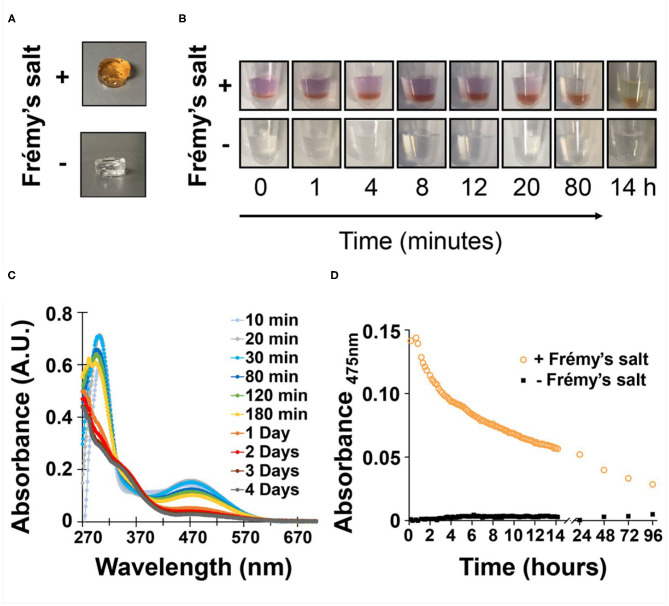
(A) Images of pre-formed gels following overnight incubation in the presence or absence of Frémy's salt. Changes in gel color observed only in the presence of Frémy's salt overtime, were monitored by (B) the naked eye as well as (C) UV-Vis spectroscopy. (D) Change in gel absorbance at 475 nm as a function of time and presence or absence of oxidant.